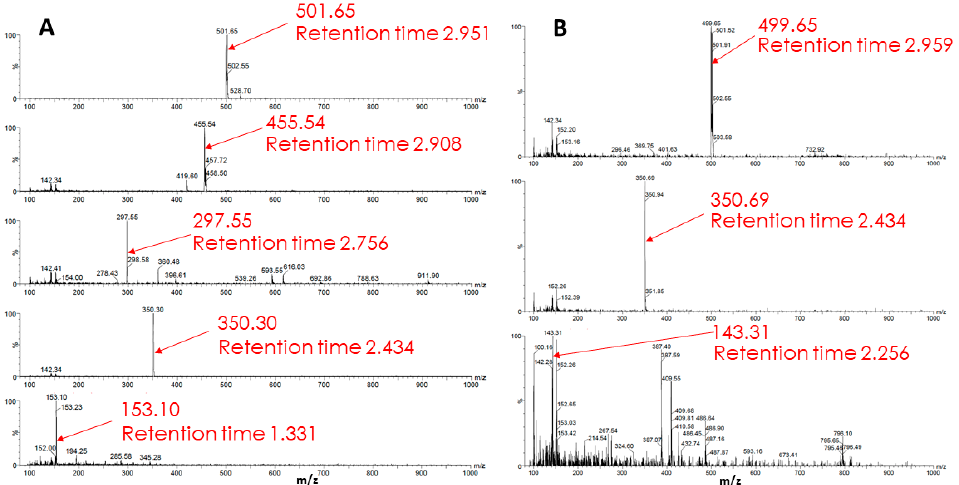
Figure 10. Mass spectrometry of metabolism products of Rh123 ( A ) and Rh110 ( B ) in glioma cells. In A, cells were cultured with rhodamine 123 (2 µM) for 2 h followed by a cultivation in rhodamine-free medium for 22 h. In B, cells were cultivated with 2 µM rhodamine 110 for 2 h.